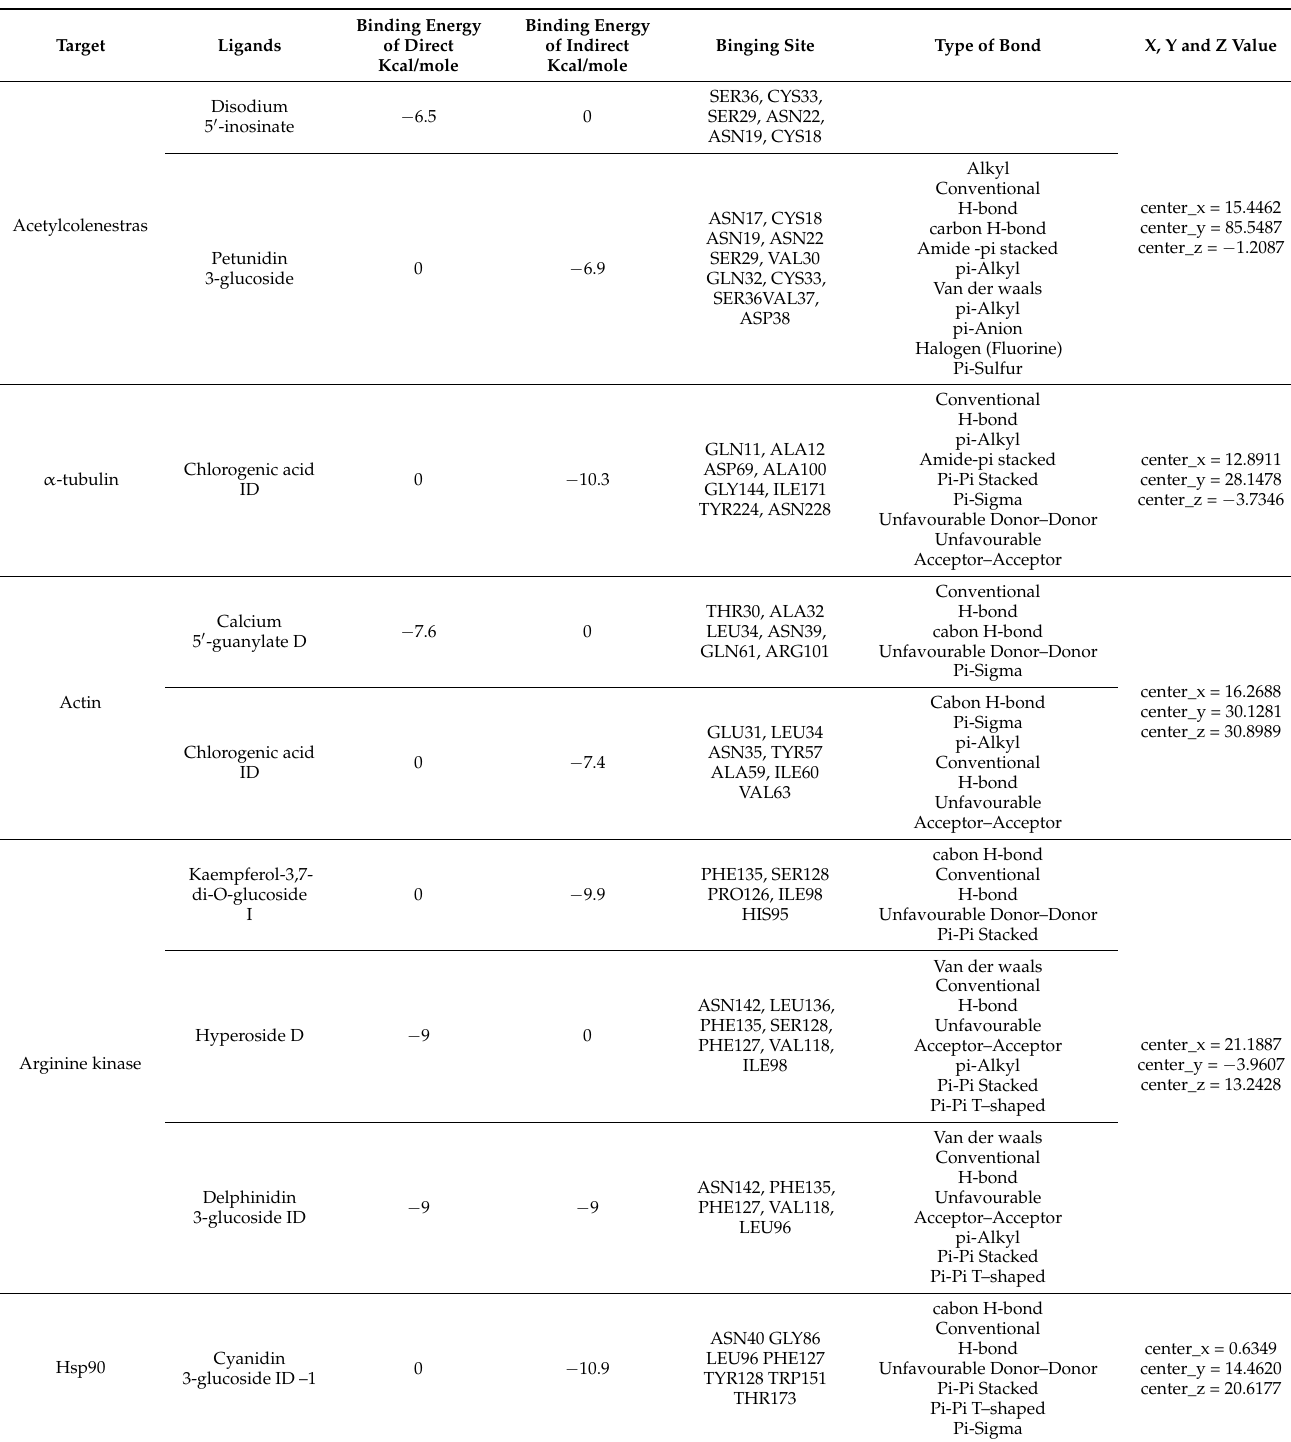
Table 3. Docking scores and molecular properties of bioactive phytochemical components from the HPLC of Phaseolus vulgaris leaves (ref) and the yeast extract compounds. The molecular docking table shows the protein target, the interactive ligands with the highest binding energy, the type of bound of the highest score ligands, and the X, Y and Z geometry values of the